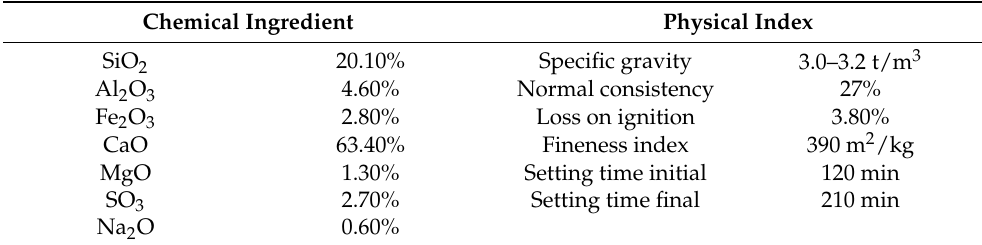
Table 2. Chemical ingredients and physical indexes of